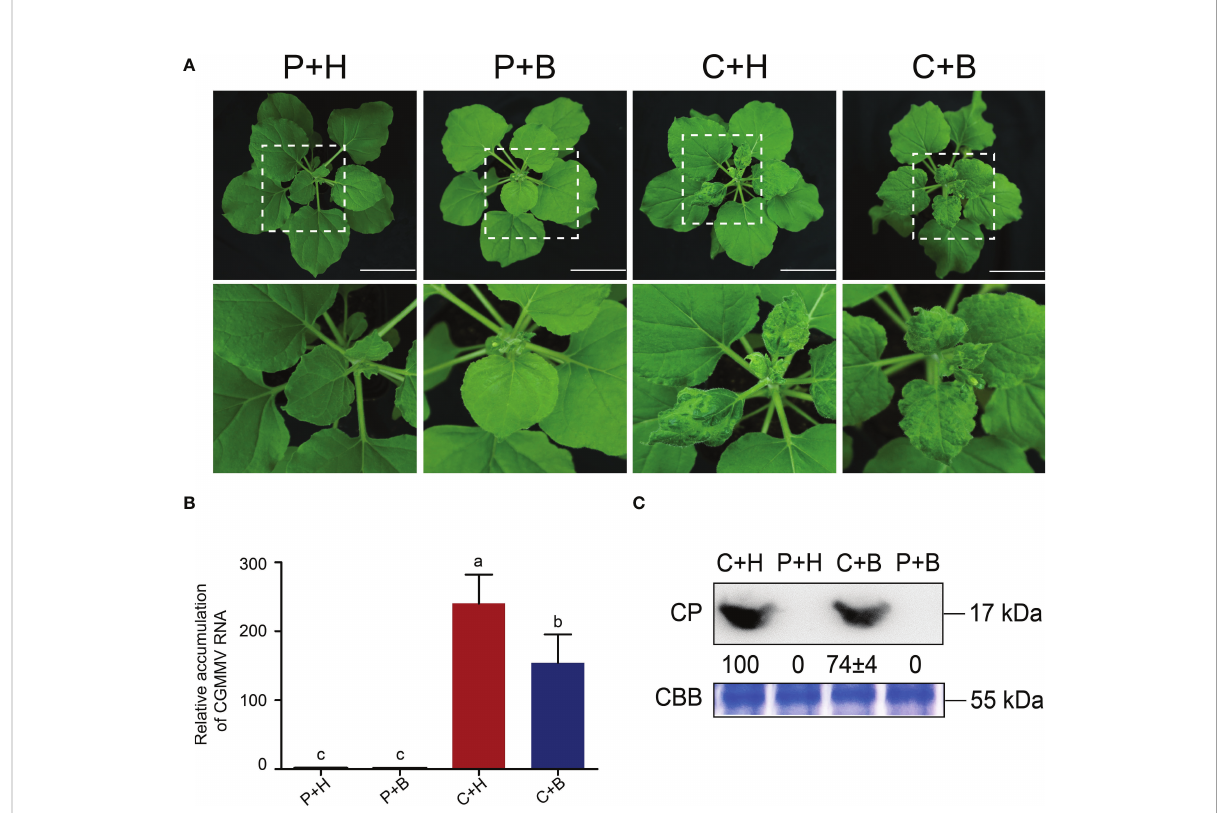
FIGURE 1 Symptoms and viral accumulation after CGMMV infection in Nicotiana benthamiana under different treatments. (A) Symptoms of N. benthamiana in four groups at 9 dpi. Scale bar = 5.0 cm. (B) The accumulation of CGMMV RNAs in upper leaves of N. benthamiana determined by RT-qPCR. Lowercase letters indicate statistical difference between treatments. The statistical signi fi cances were determined using one-way analysis of variance followed by Duncan ’ s multiple comparison test ( P value < 0.05). (C) The accumulation of CGMMV CP in upper leaves of N. benthamiana determined by Western blotting. Coomassie brilliant blue stained cellular proteins were used as loading